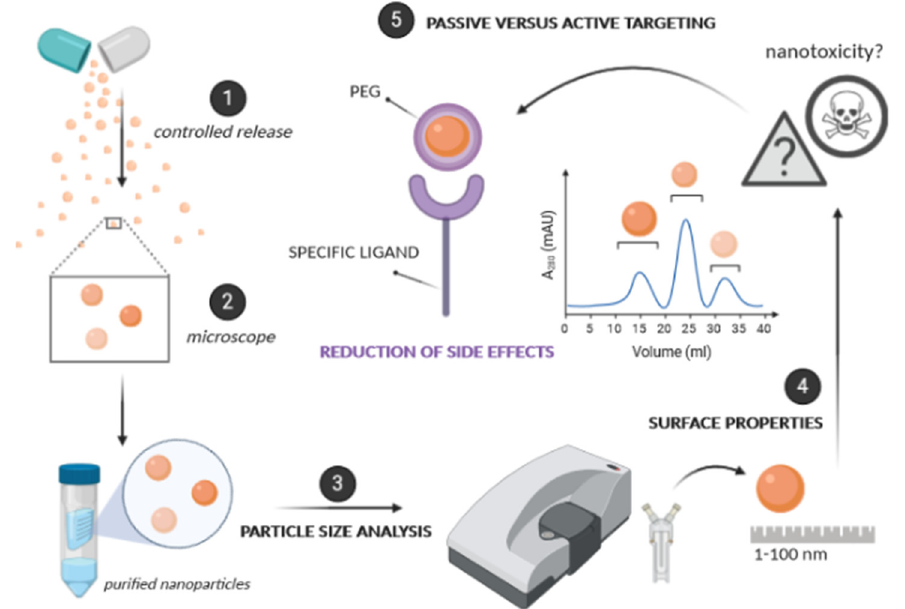
Figure 4. Graphical summary of the most important features of nanoparticles towards their successful implementation for healthcare applications [own drawing]. Explanations of the key stages of the implementation process for nanoparticles: 1—controlled drug release; 2—microscope analysis (SEM, TEM, SPM); 3—particle size analysis (DLS, SLS, ZP); 4—assessment of the surface properties; 5—evaluation of passive/active drug targeting.